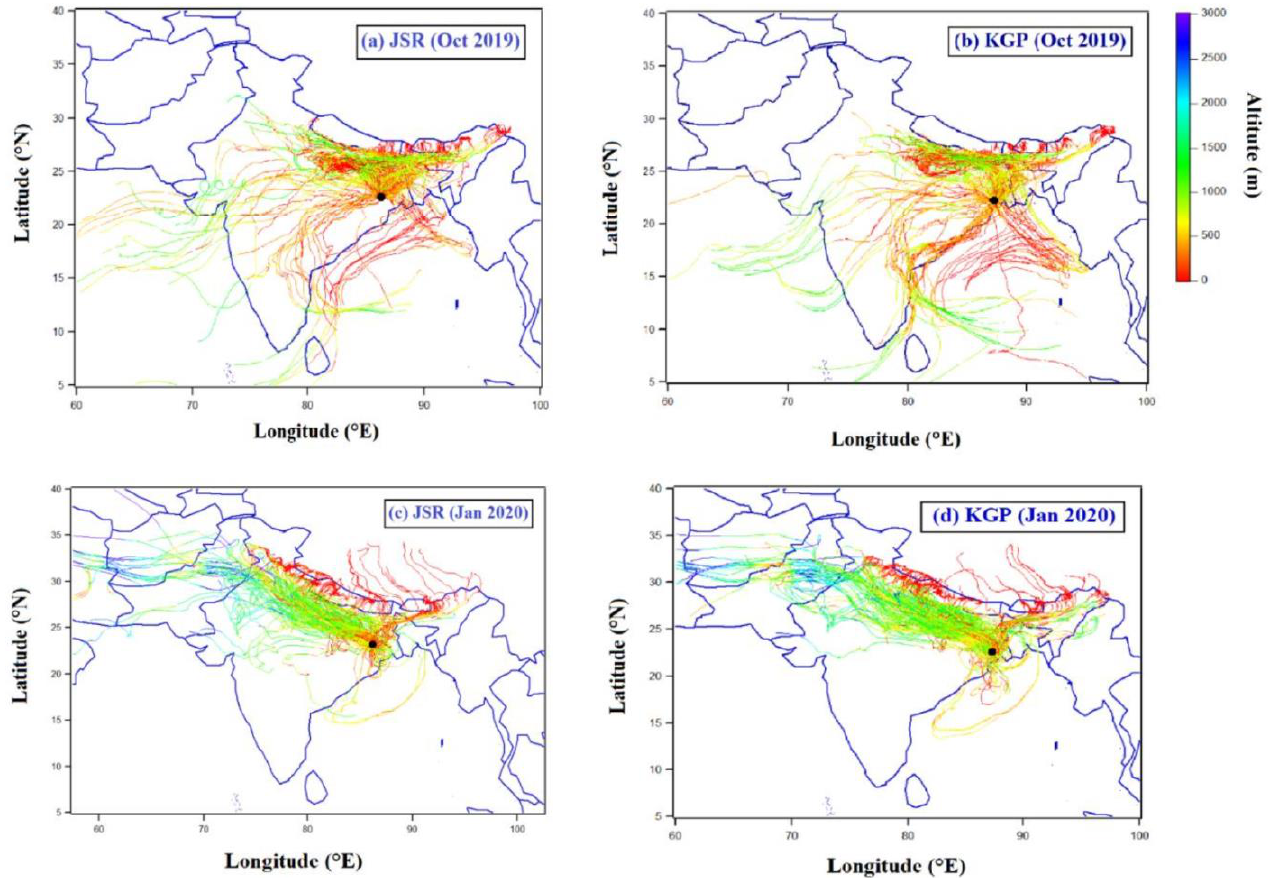
Figure 7. Seven-day air mass back trajectories over JSR and KGP sites starting at 500 m from ground level.